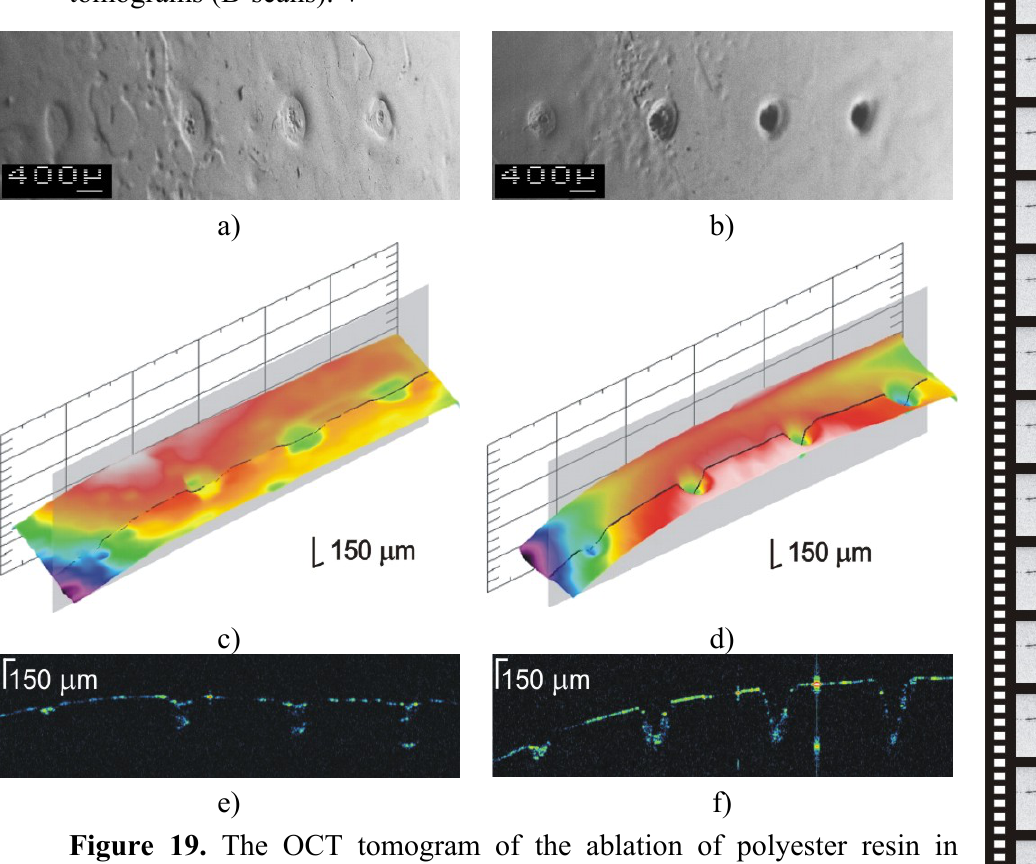
Figure 18. Testing of ablation conditions of Polyester resin in styrene without matting agent with two irradiation fluences: a,c,e) 4 J/cm 2 , and b,d,f) 7 J/cm 2 . In both cases, craters were formed by accumulation of 1, 2, 5, and 10 laser pulses (from the left to the right). a,b) SEM surface microphotographs; c,d) surface maps recovered from OCT data ; e,f) OCT tomograms (B-scans). ↓